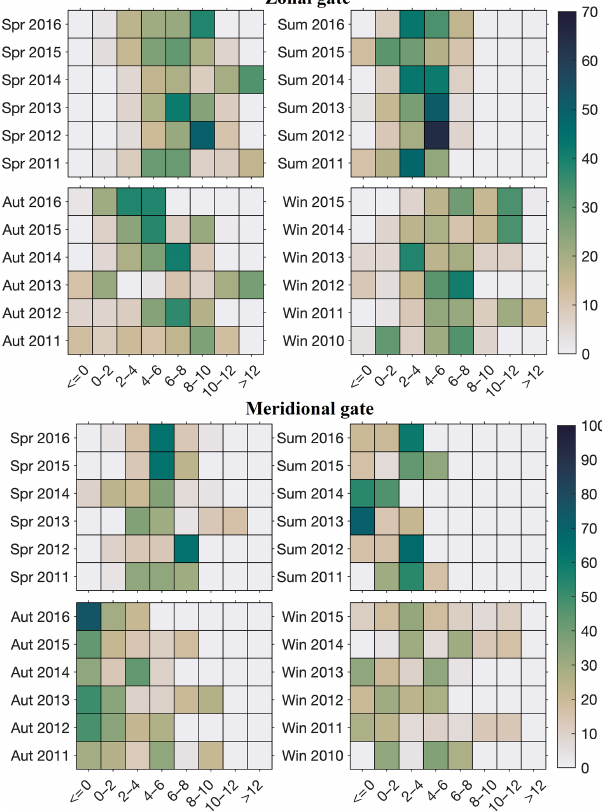
Figure 9. Seasonal variation in relative frequency (unit: %) of CMST sea ice drift (unit: kmd − 1 ) over the entire Fram Strait gate.